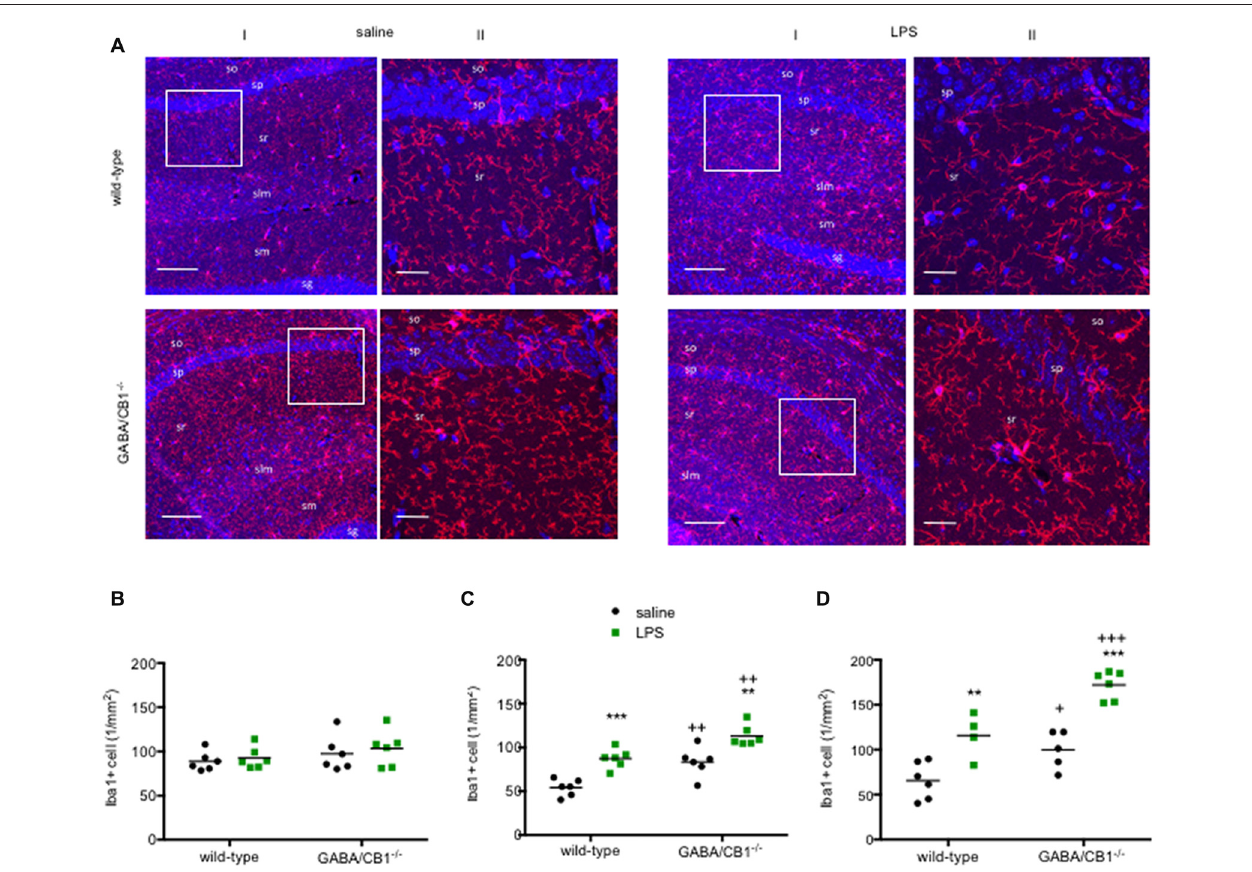
FIGURE 2 | (A) Representative microphotograph of Iba1 immunostaining (red) and DAPI fluorescence showing cell nuclei (blue) in the hippocampus of WT and GABA/CB1 − / − mice 24 h after four times daily intraperitoneal LPS injections. (I) Low magnification image, the scale bar represents 100 µ m. White quadrant shows the region presented as high magnification image. (II) High magnification image, the scale bar represents 25 µ m. so—stratum oriens; sp—stratum pyramidale; sr—stratum radiatum; slm—stratum lacunosum moleculare; sg—stratum granulosum. Density of Iba1-positive (Iba1+) microglia cells in the hippocampus of WT and GABA/CB1 − / − mice (B) Three hours after an intraperitoneal LPS-treatment. (C) Twenty-four hours after an intraperitoneal LPS-treatment. (D) Twenty-four hours after four times daily intraperitoneal LPS injections. ∗∗ p < 0.01; ∗∗∗ p < 0.001 difference between saline and LPS-treated mice using Bonferroni’s t -test. ++ p < 0.01; +++ p < 0.001 difference between WT and GABA/CB1 − / − mice with the same treatment using Bonferroni’s t -test. + p <